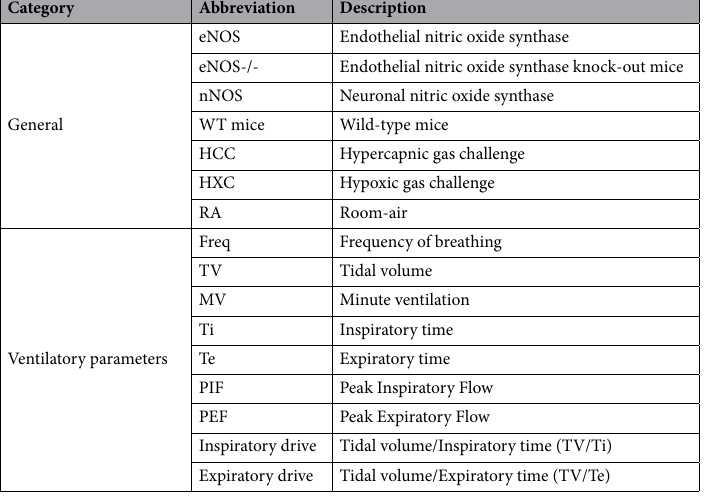
Table 1. List of